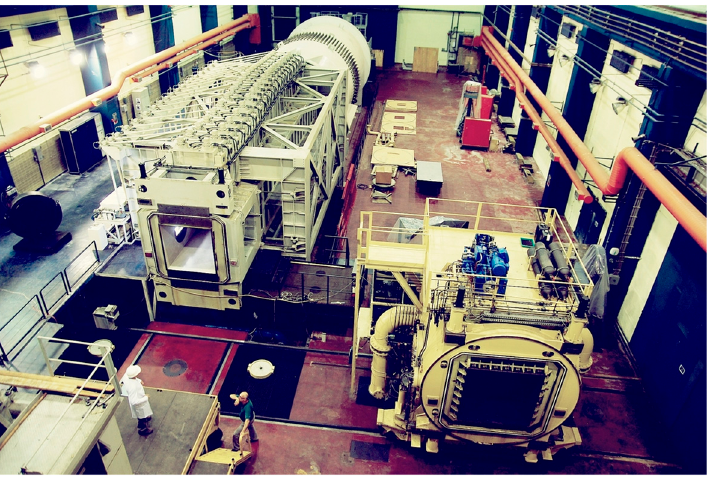
Figure 2. The T-38 test facility in VTI, Belgrade.